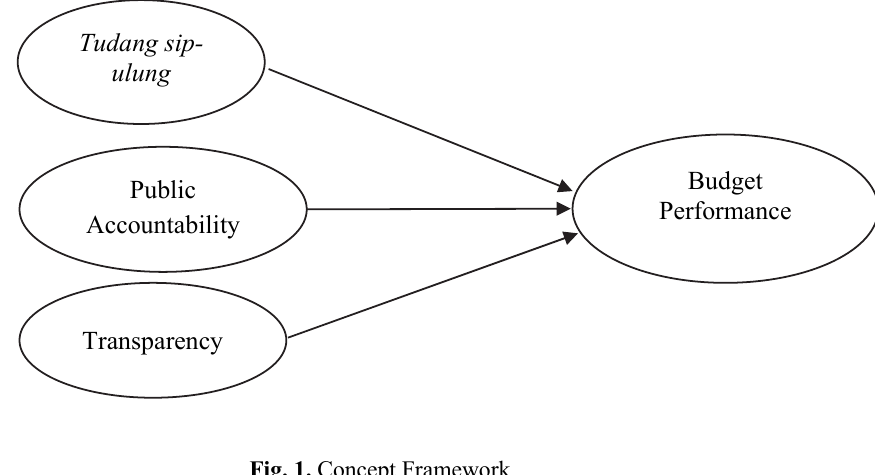
Fig. 1. Concept Framework